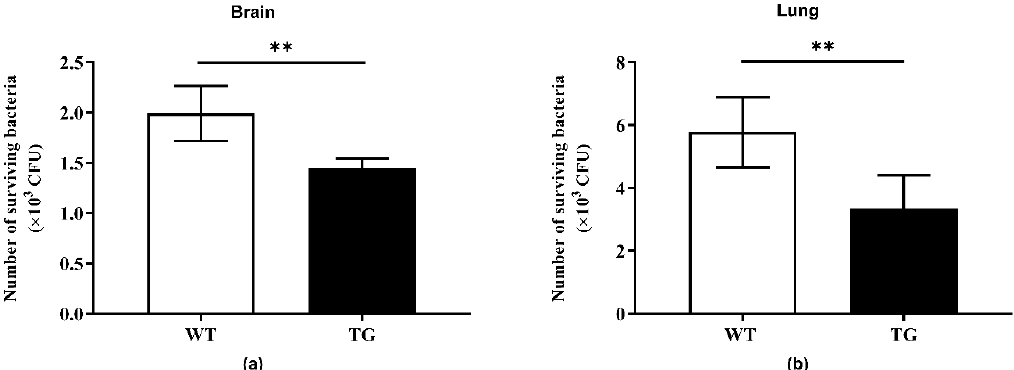
Figure 4. Brain ( a ) and lung ( b ) homogenates from the TG pigs ( n = 5) displayed enhanced antibacterial activity against G. parasuis when compared with those from the WT pigs ( n = 6). Brain or lung tissues of 400 mg from each pig were homogenized and centrifugated, and heat-inactivated supernatants were mixed with G. parasuis (2.5 × 10 3 colony-forming units) at 37 °C for 1 h. The number of surviving bacteria in the mixture was counted. Data are presented as mean ± SD and plotted from three independent experiments. ** p < 0.01, unpaired one-tailed Student ′ s t -test.